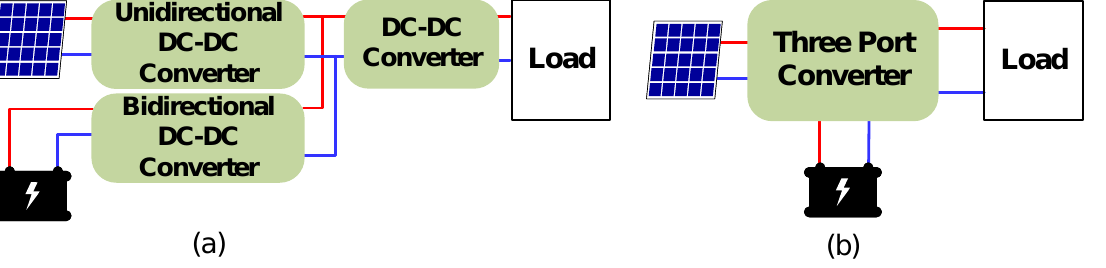
Figure 1. Renewable power systems: ( a ) separate DC–DC converter, and ( b ) three-port converter